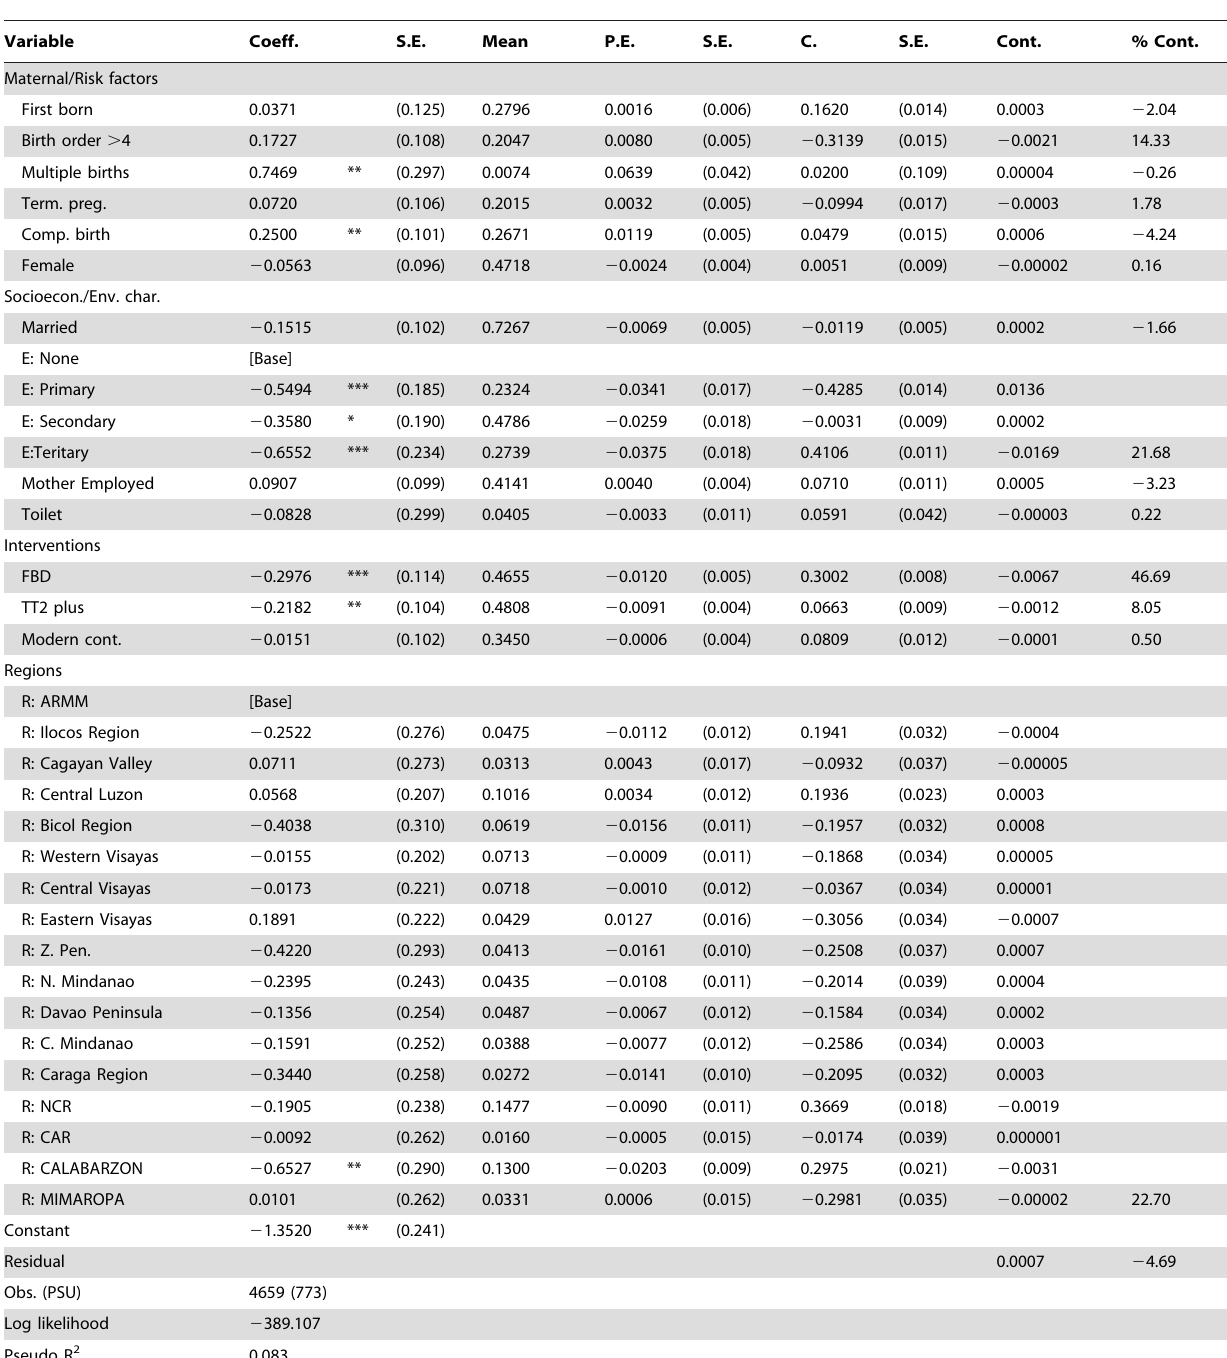
Table 2. Decomposition analysis of inequality in under-five mortality, Philippines 2008.